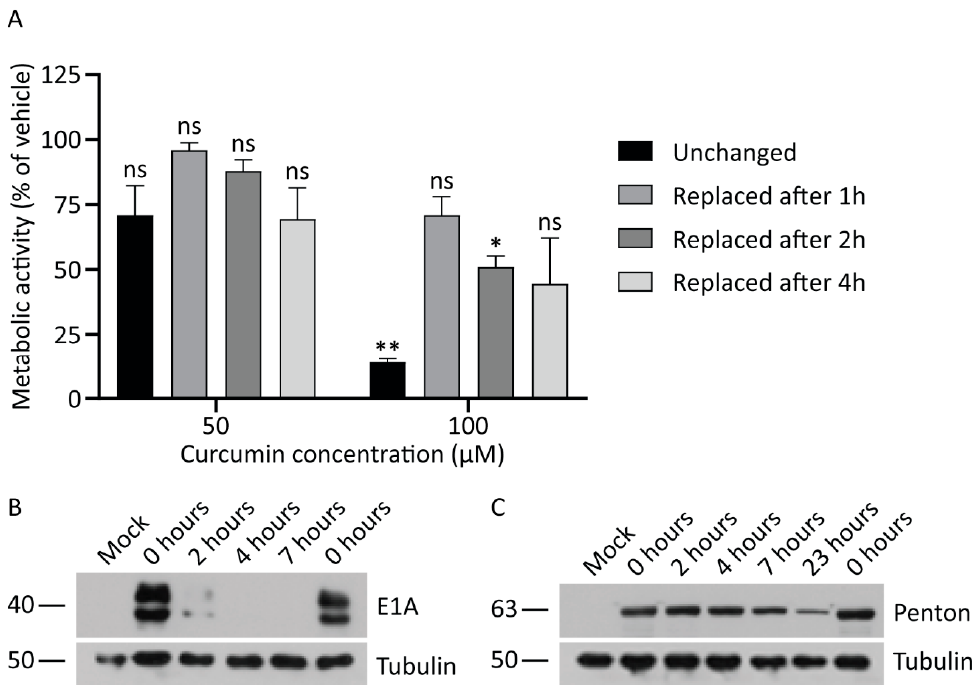
Figure 4. Treatment with curcumin reduces viral yield. A549 cells were infected with HAdV-5 at an MOI of 10 for 1 h and overlaid with medium containing curcumin (0, 25, 50, and 100 µM). Twenty-four hpi, the cells were harvested into the medium, and the titer of recovered viruses was analyzed by plaque assay. The mean of three experiments are shown, and the error bars represent standard deviation (SD) of the mean. * p ≤ 0.05. Microorganisms 2020 , 8 , x FOR PEER REVIEW 10 of